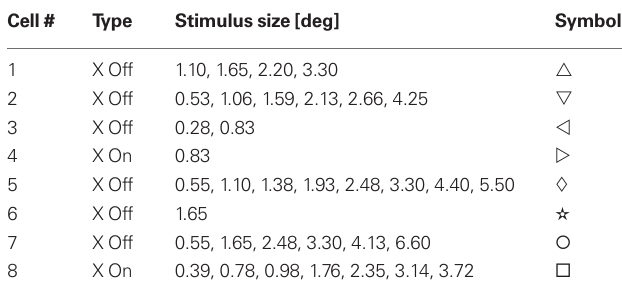
Table 1 | Summary of recorded cells and stimulus